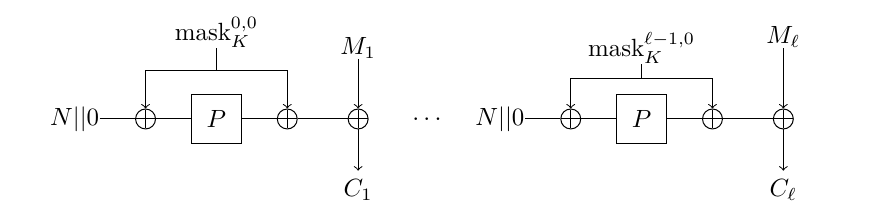
Figure 6: Elephant encryption of the message ( M i